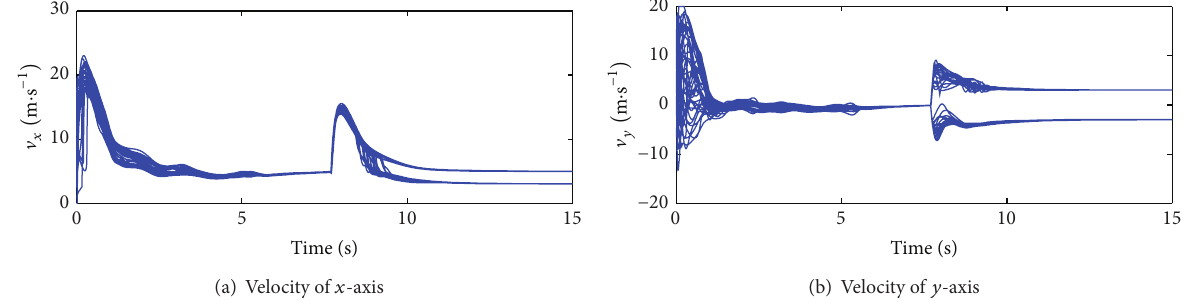
Figure 4: Velocity of individuals during the fission process.